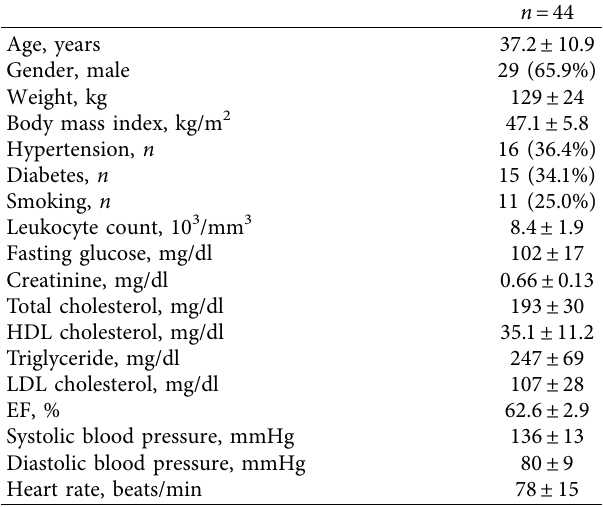
Table 1: Demographic features, baseline laboratory measurements, and clinical characteristics of the study